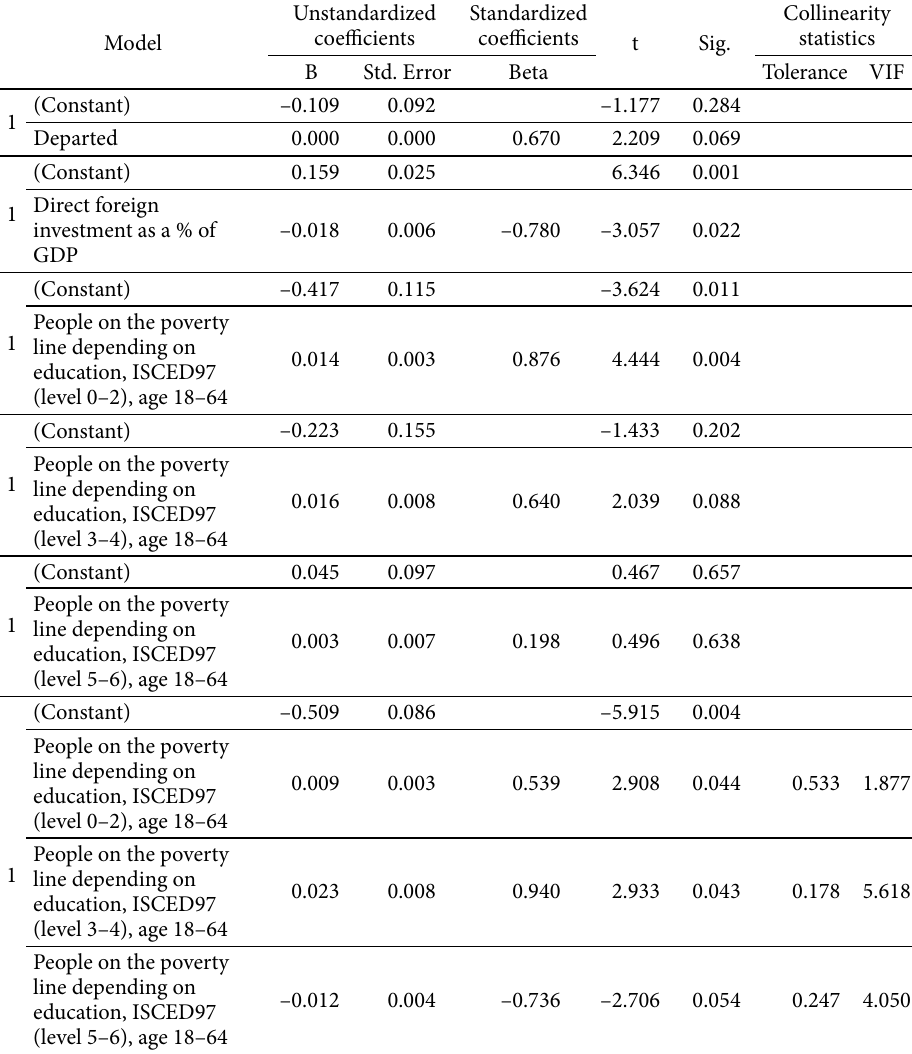
Table 13. Coefficients of estimation of the interdependence between the shadow economy power and human capital